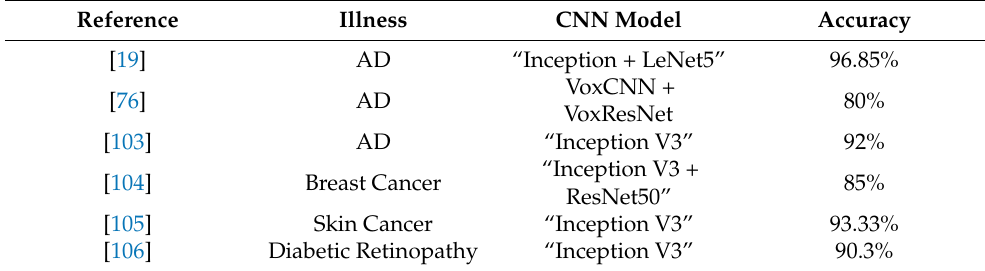
Table 2. CNN architectures for detection of AD and other